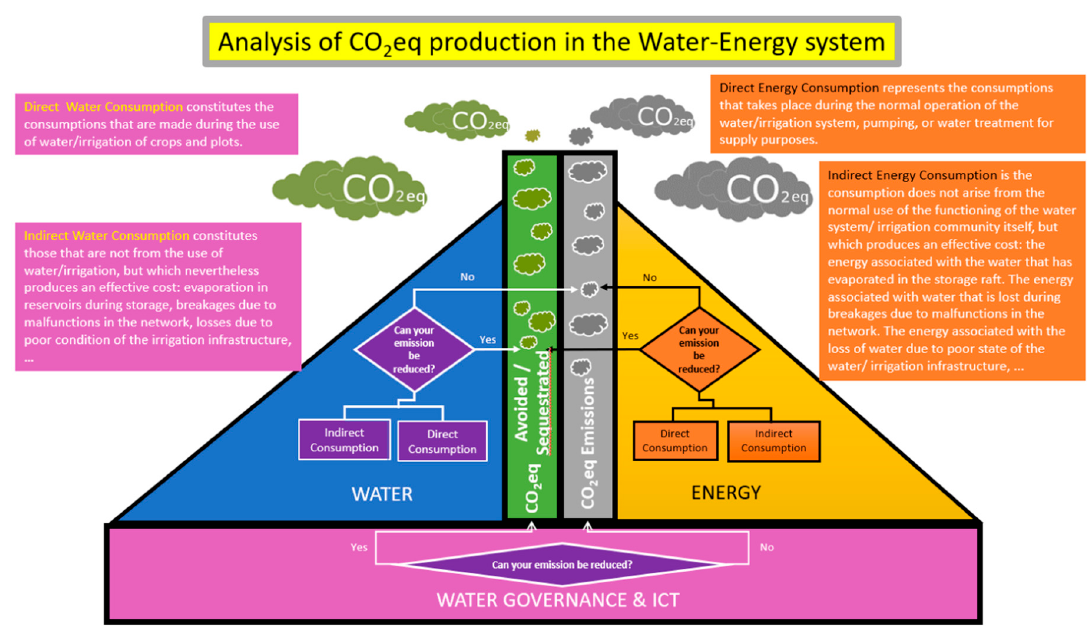
Figure 1. CO 2 eq analysis production in a Water-Energy system. Source: Own elaboration.